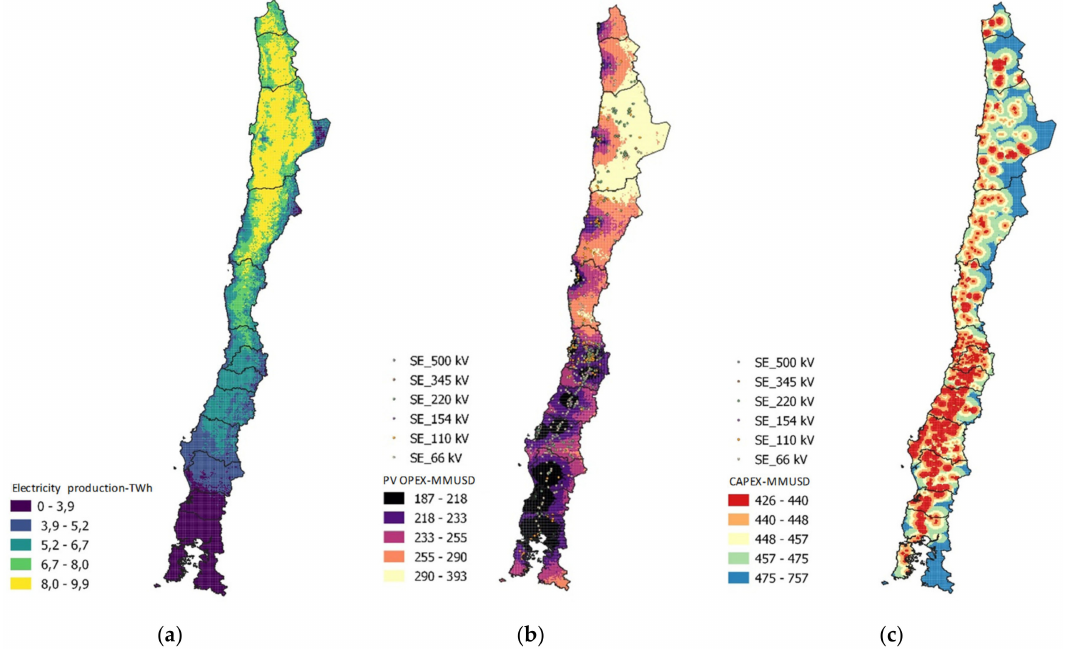
Figure 5. Maps of the total electricity production during the lifetime of the CSP tower plant ( a ), the present value of OPEX costs in the lifetime ( b ), and the CAPEX costs involved in the installation of the power plant ( c